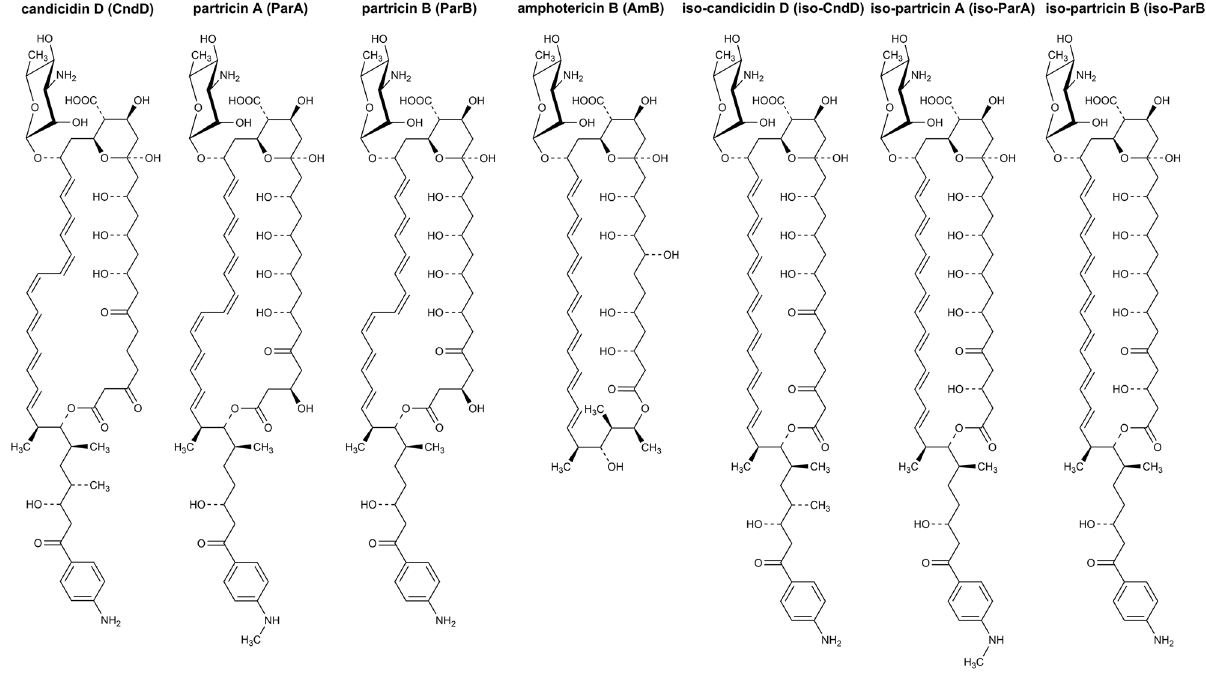
Figure 1. The structures of amphotericin B (AmB), native (cis-trans) aromatic heptaene macrolides (CndD, ParA, ParB) and their all-trans photoisomers (iso-CndD, iso-ParA,